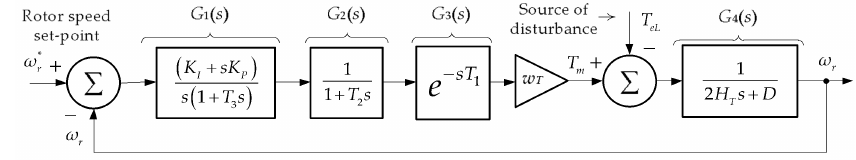
Figure 12. Aggregate representation of the diesel power plant in the